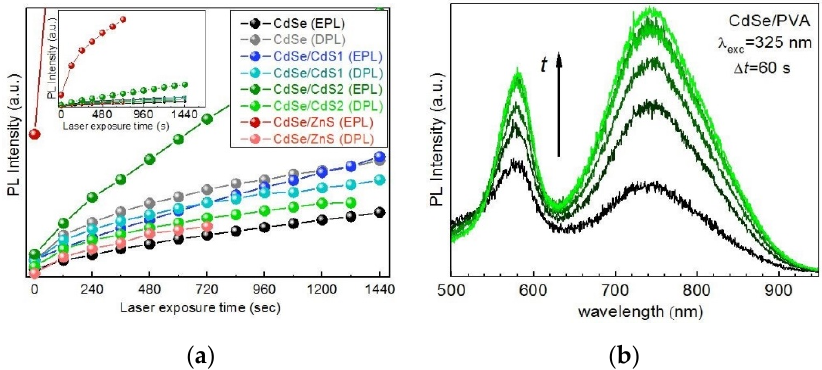
Figure 5. ( a ) Time evolution of the room-temperature PL intensity ( λ exc = 325 nm) of CdSe, CdSe/CdS, and CdSe/ZnS NCs in gelatin matrix. The integrated PL intensity was derived from the time-resolved series of spectra like those in the Figures 2 and 4. The inset shows the same dependences but in a full intensity range of the EPL of CdSe/ZnS ( b ) Evolution (from black to green) of the room-temperature PL spectra ( λ exc = 325 nm) of CdSe NCs in PVA matrix.